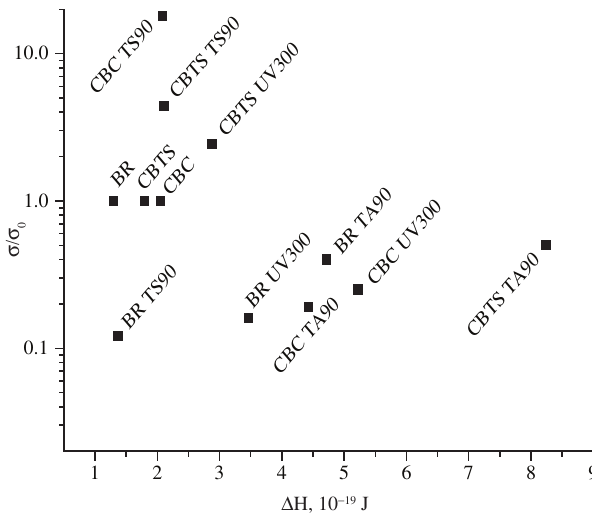
Figure 9. The σ / σ o vs. ∆ H plot for all the samples,before and after ageing treatments.